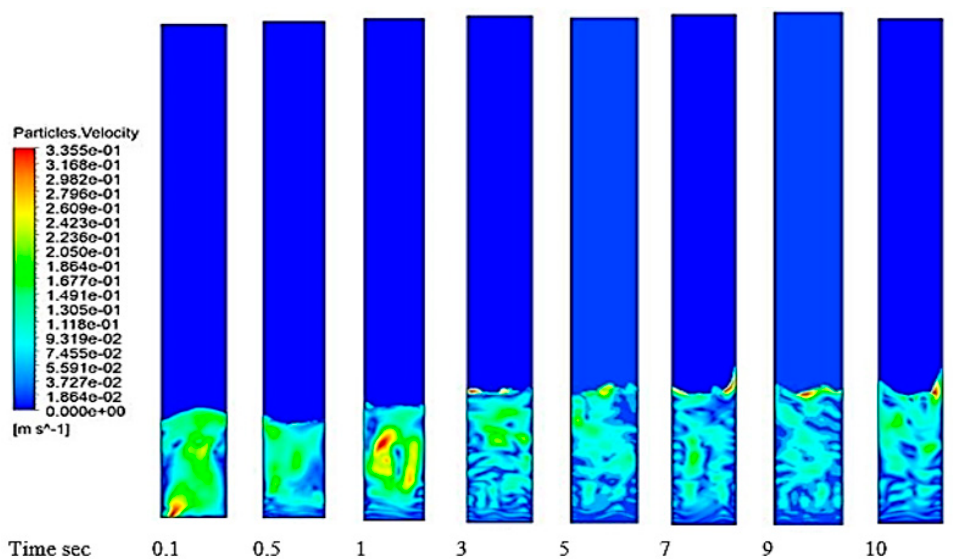
Figure 16. The velocity contour of particles with a diameter of 6 mm with time.